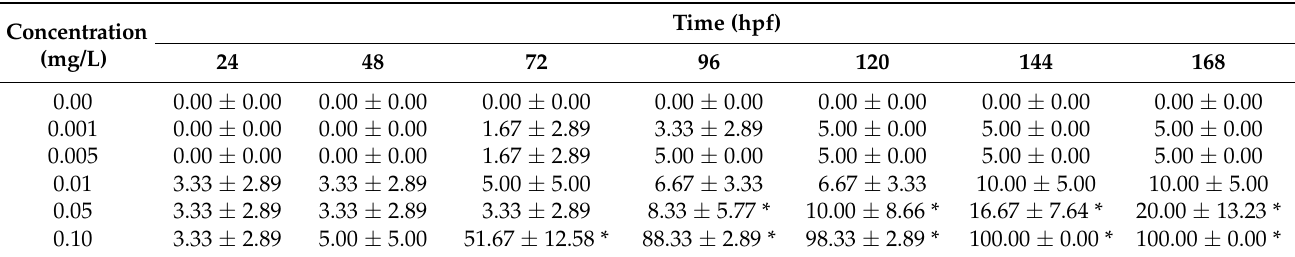
Table 3. Cumulative mortality of rare minnow at embryo and sac-fry stages after exposure to different concentrations of Hg 2+ .